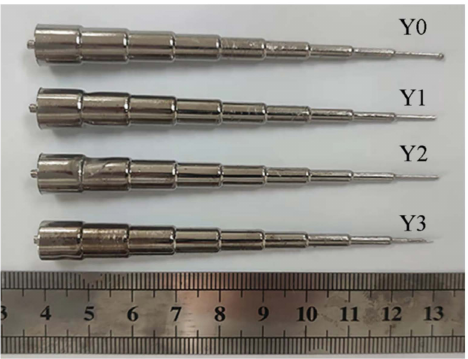
Figure 1. Photograph of the Y0, Y1, Y2, and Y3 specimens with cylindrical